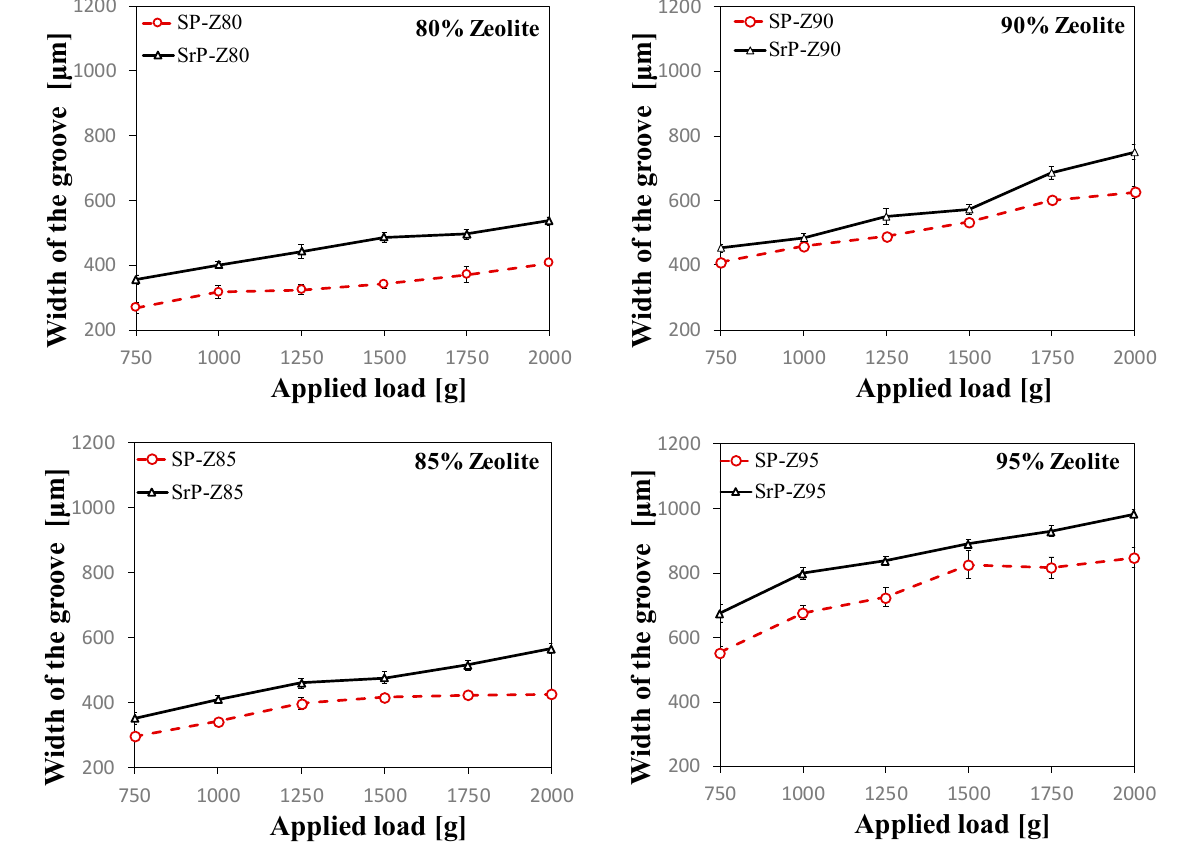
Figure 3. Comparison of groove widths in S-PEEK (SP-Z) and S-rPEEK (SrP-Z) at varying zeolite content.